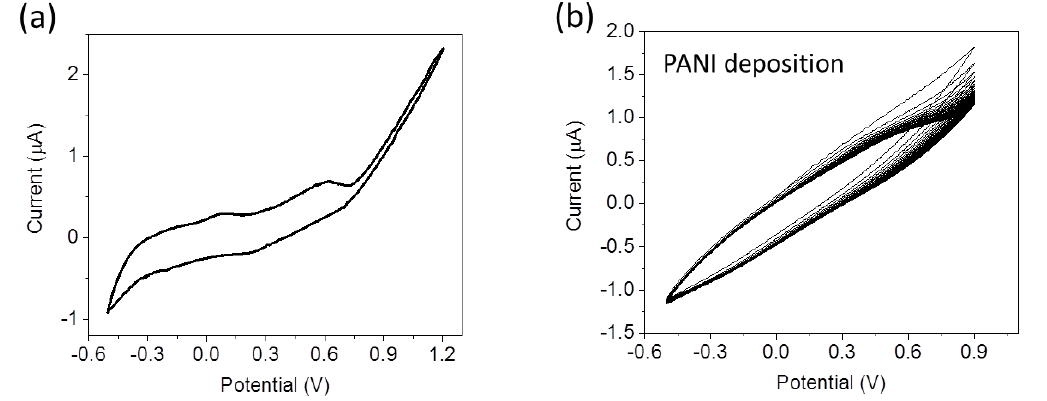
Figure 4. ( a ) Cyclic voltammetry measured in the aniline solution (0.05 M aniline + 0.1 M KCl) recorded at a scan rate equal to 10 mV/s; ( b ) PANI deposition by 80 CV cycles at 100 mV/s scan